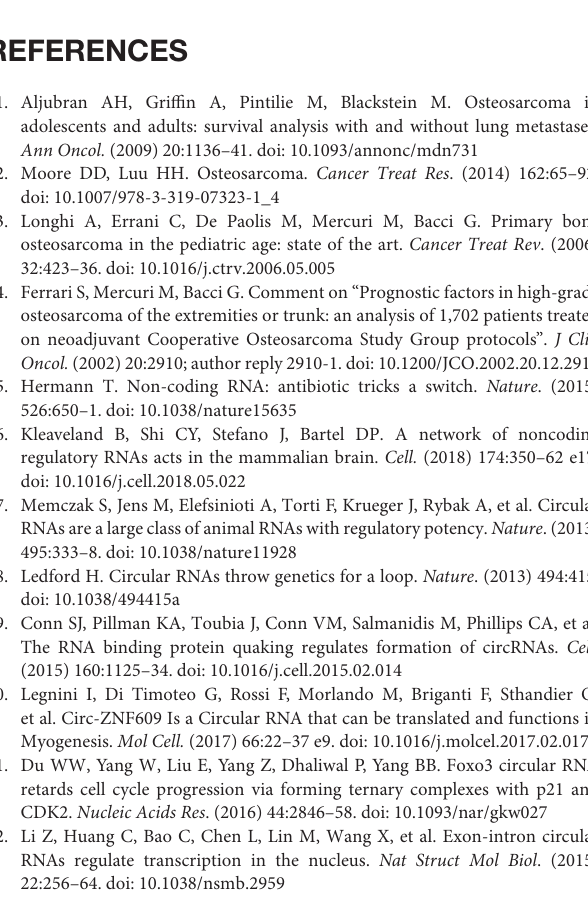
Figure 4 . ∗ p < 0.05 vs. control. # p < 0.05 vs. sh-circ0085539 group. (B) The expression of miR-526b-5p and PHLDA1 in cells after colony formation experiments in Figure 6 . ∗ p < 0.05 vs. control. # p < 0.05 vs. sh-PHLDA1 group. Supplementary Figure 4 | Confirmation of the circular structure of circ0085539, and the expression of circ0085539 and PHLDA1 in tissue samples. (A) The existence of circ0085539 was validated in osteosarcoma and adjacent tissues using agarose gel electrophoresis. Divergent primers detected circular RNAs in cDNA but not in gDNA. GAPDH was used as the negative control. ◮◭ , convergent primer; ◭◮ , divergent primer. (B) Another 20 pairs of osteosarcoma tissues and adjacent tissues were collected. 10 of them were randomly assigned to training dataset while the other 10 were assigned to the validation dataset. In the two datasets, circ0085539 expression was detected. In this way, the ensurance of the upregulation of circ0085539 in osteosarcoma was enhanced. The training set and validation set method eliminated the falses to a maximum. Normal: adjacent tissues. ∗ p < 0.05 vs. normal group. (C) The IHC results showing the expression of PHLDA1 in osteosarcoma and adjacent tissues. Supplementary Table 1 | The sequences of the siRNAs and inhibitor in this study. Supplementary Table 2 | the 33 upregulated DEGs were screened out from GSE49003 with p -value < 0.05 and logFC > 2. Supplementary Table 3 | The target genes of miR-526b-5p were predicted by ENCORI starBase. Supplementary Table 4 | The target genes of miR-526b-5p were predicted by Tarbase